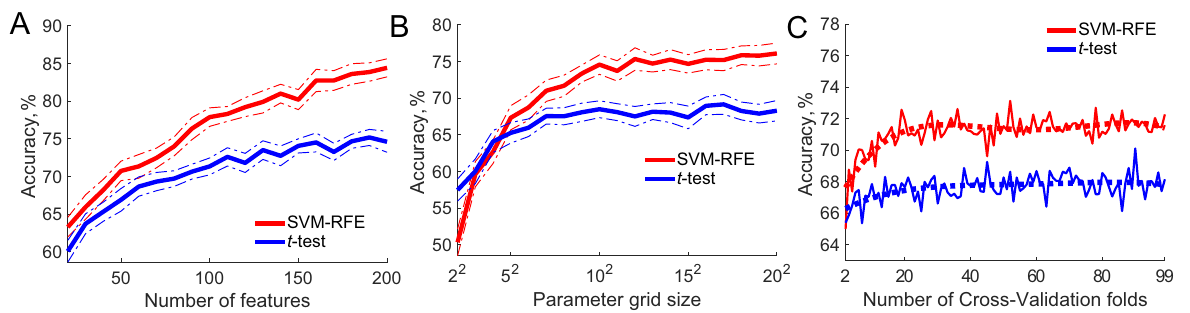
Fig 4. Other factors apart from sample size influencing overfitting when K-Fold CV is used. SVM-RFE and t -test feature selection, SVM classification, and sample size fixed at N = 100. A : Feature number manipulated from 20 to 200. B : Parameter tuning grid size manipulated from 2 × 2 to 20 × 20 with C = 2 j , where j varied from 2 to 20 and γ = 2 i , where i varied from − 2 to − 20. C : Number of CV folds varied from two-fold to leave-one out. Thick dashed lines show fitted 5 th order polynomial trend.